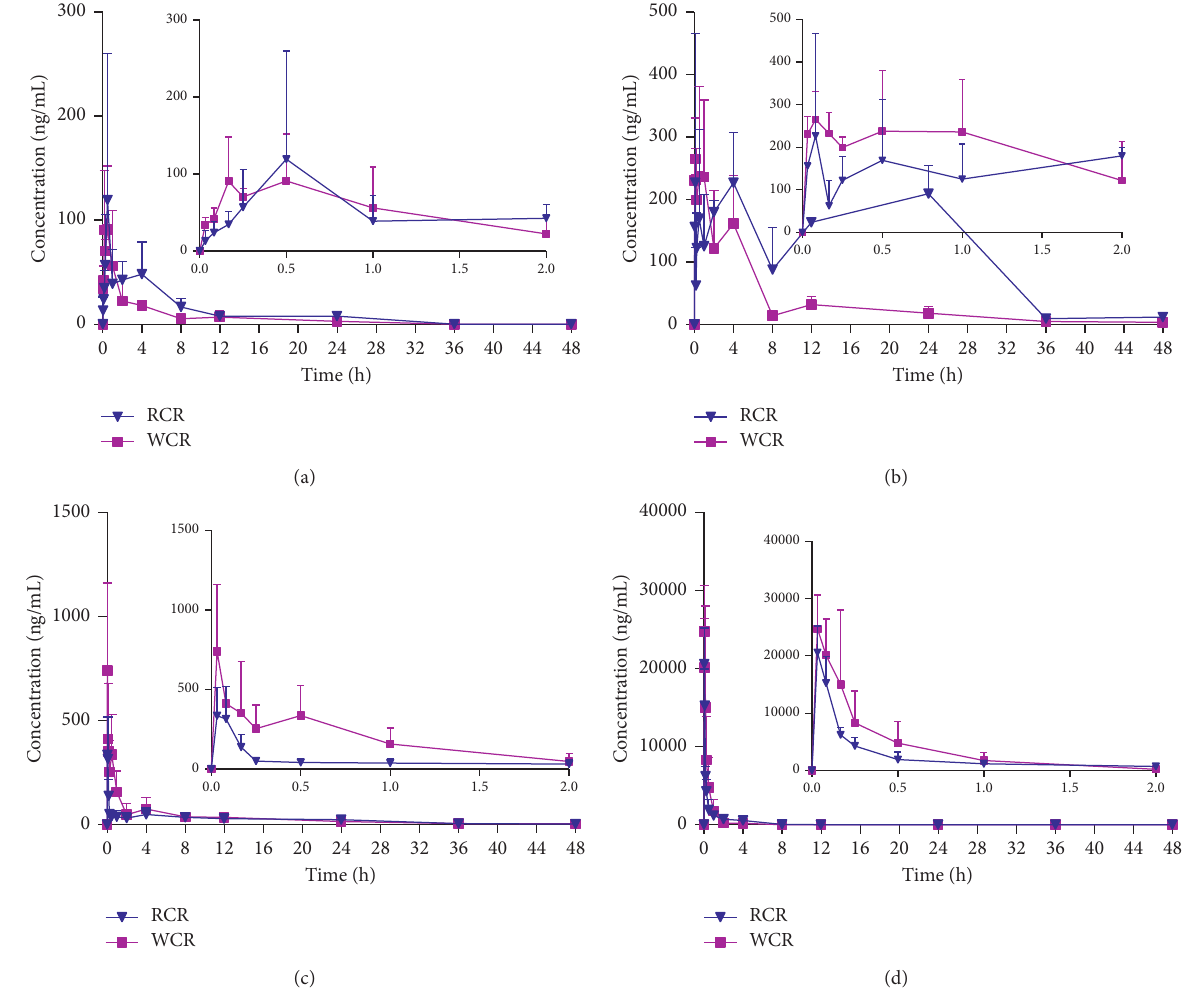
Figure 4: Mean plasma concentration-time curves of butylidenephthalide (a), ligustilide (b), senkyunolide A (c), and ferulic acid (d) after oral administration of RCR and WCR to MCAO rats (mean ± SD, n �